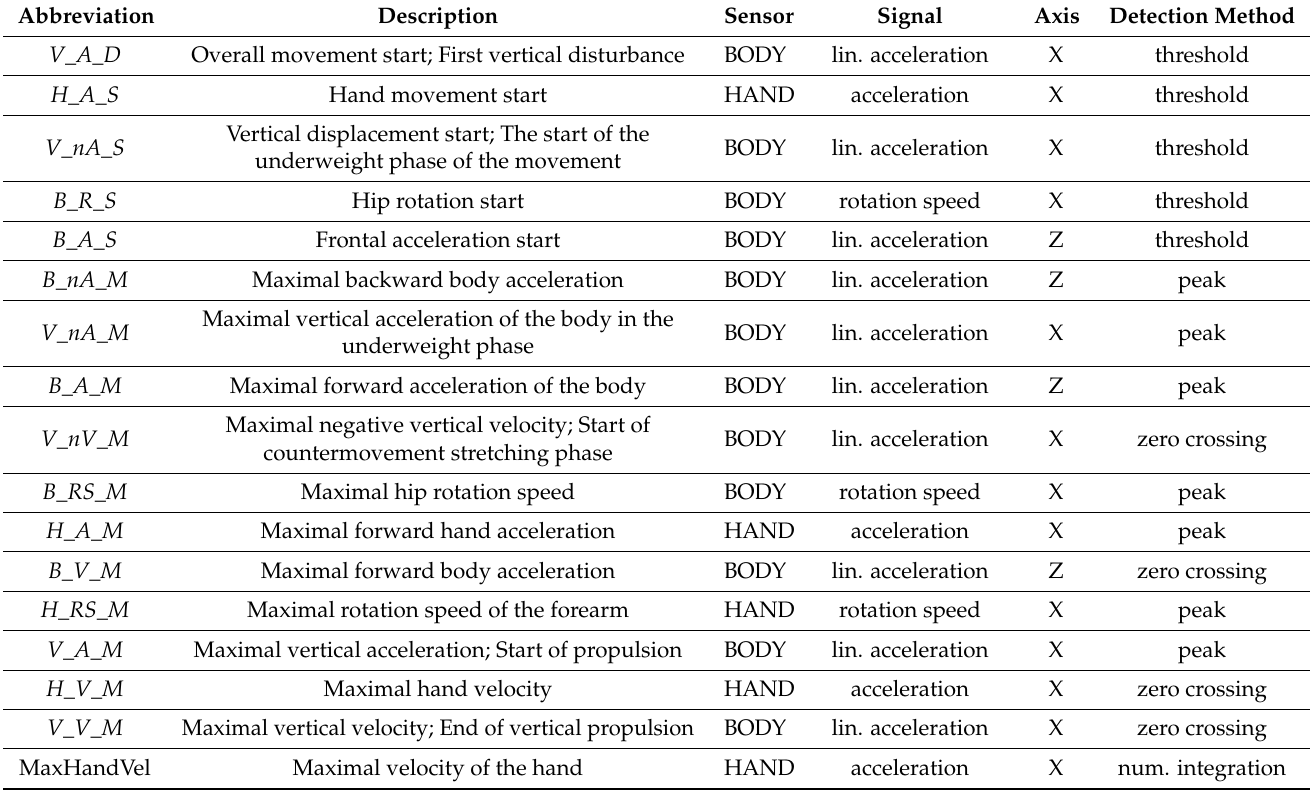
Table 1. Detailed description of the